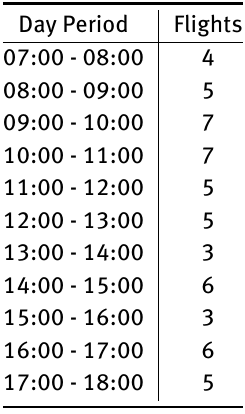
Table 3: Number of flights per hour Day Period